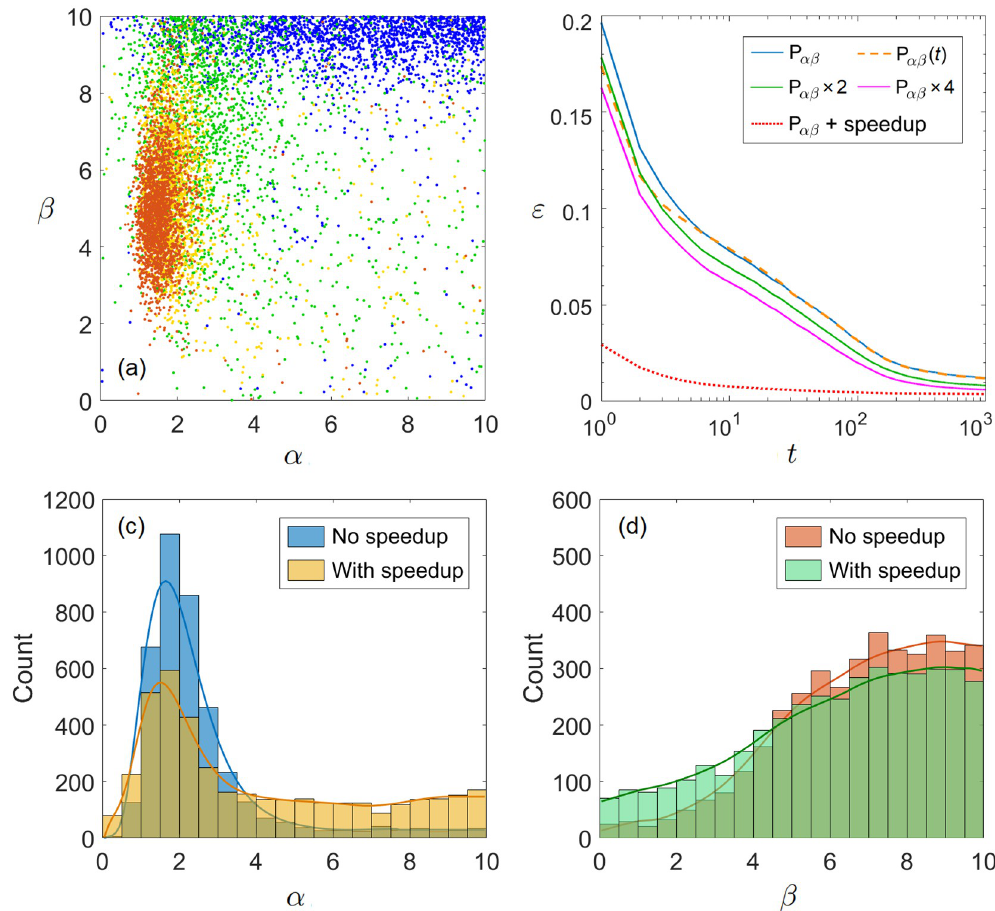
Fig 2. Effects of problem stage and computing power. (a) The P α , β ( t ) distribution with t = 1–5, 6–30, 31–100 and 101–1000 scatter plotted in blue to red. (b) Error curves of P α , β ( t ) compared with P α , β and other variations. Panels (c)–(d) compare the P α , β distributions with and without the Hamiltonian cycle speedup. Number of vertices N = 100 in all 4